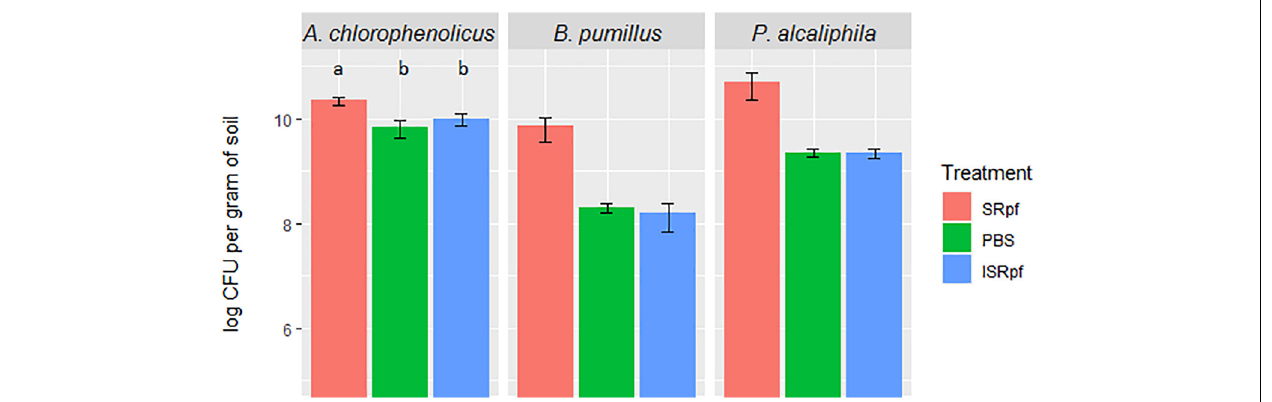
FIGURE 2 | CFUs of each bioaugmented strain present per gram of soil after 1 day of extraction with SRpf, PBS, or ISRpf. B. pumilus and P. alcaliphila exhibited the highest increase in CFU numbers after extraction with SRpf (more than one order of magnitude versus controls). The number of CFUs for A. chlorophenolicus were significantly different among the different treatments (ANOVA, F = 105.83, d.f .1 = 2, d.f. 2 = 42, P < 0.001). Post hoc comparisons (Tukey honest significant differences) show that the A. chlorophenolicus CFU numbers for the three conditions significantly differ from each other ( P < 0.05).